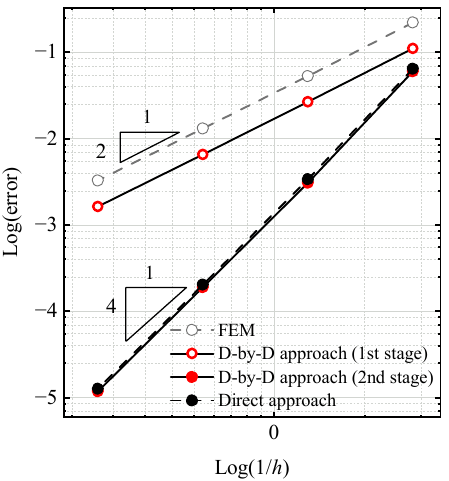
Figure 5. Errors of nodal displacements for the test problem.